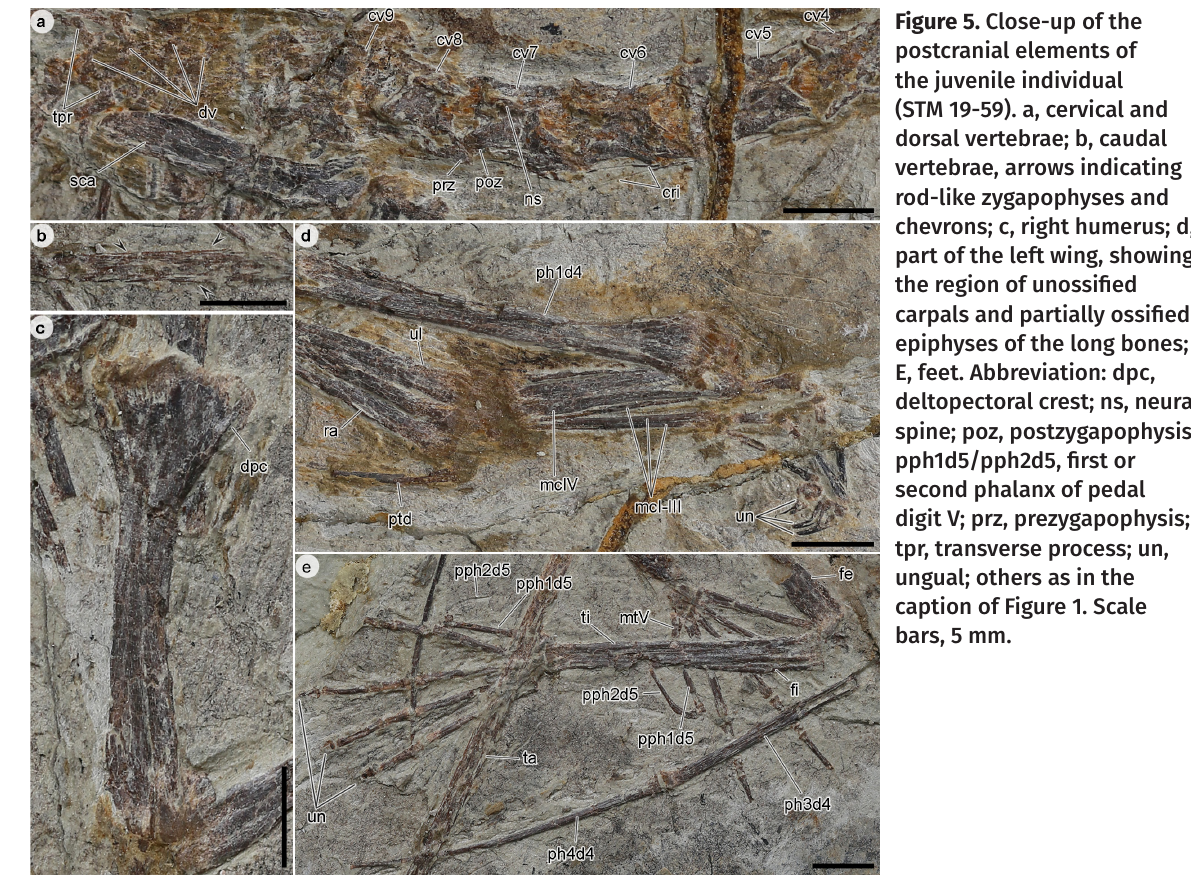
Figure 5. Close-up of the postcranial elements of the juvenile